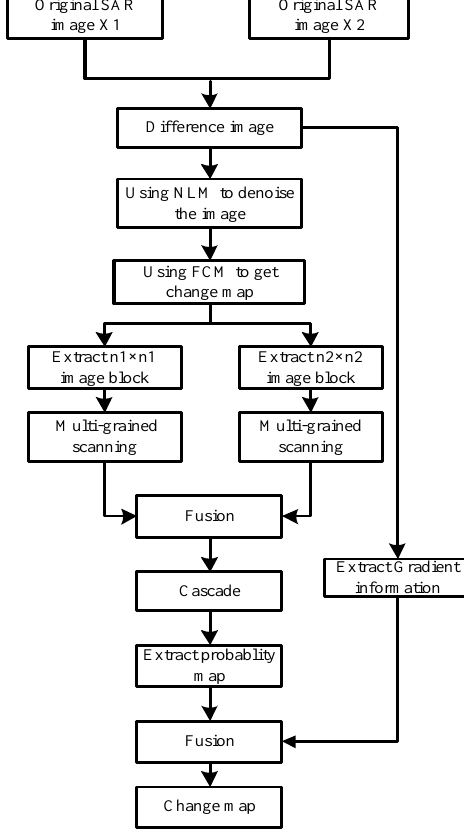
Figure 3. Flowchart of the proposed